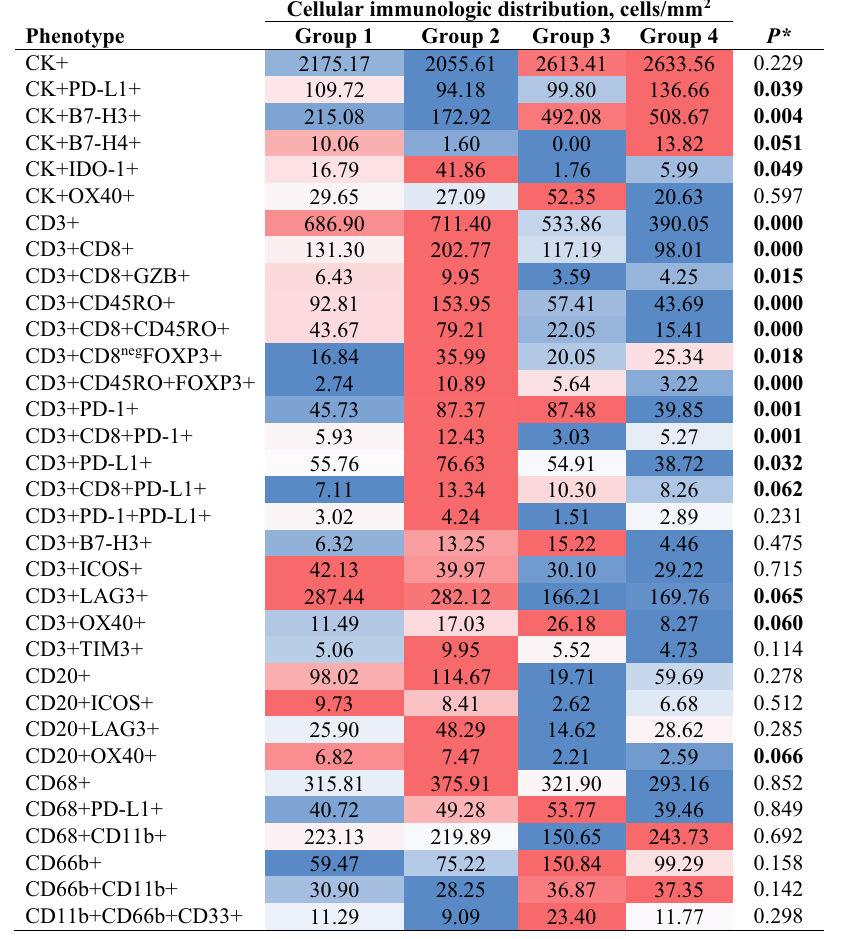
Table 3 | Cell phenotype densities according the cellular immunologic distribution based on CD3 + T-cells in non-small cell lung cancer ( n =